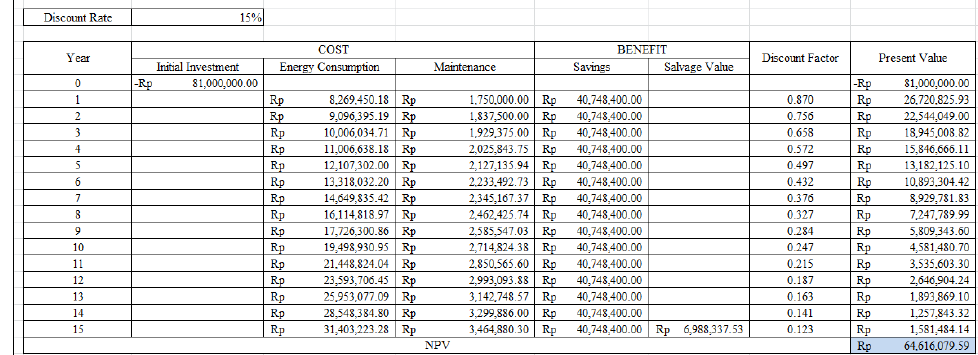
Figure 4. NPV calculation.